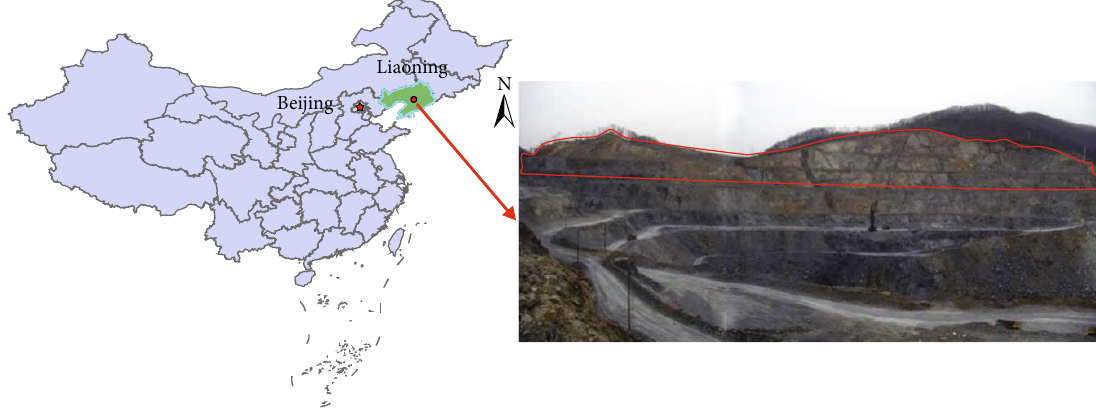
Figure 1: Rock slope panorama. Table 1: Dominant grouping of joint fi ssures at the observation